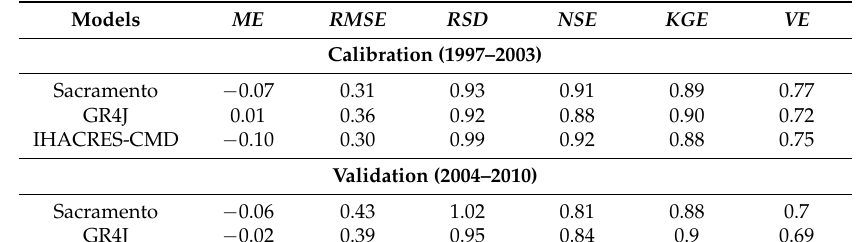
Table 3. Comparative efficiencies of three hydrological models (IHACRES Catchment Moisture Deficit—CMD, GR4J and Sacramento).